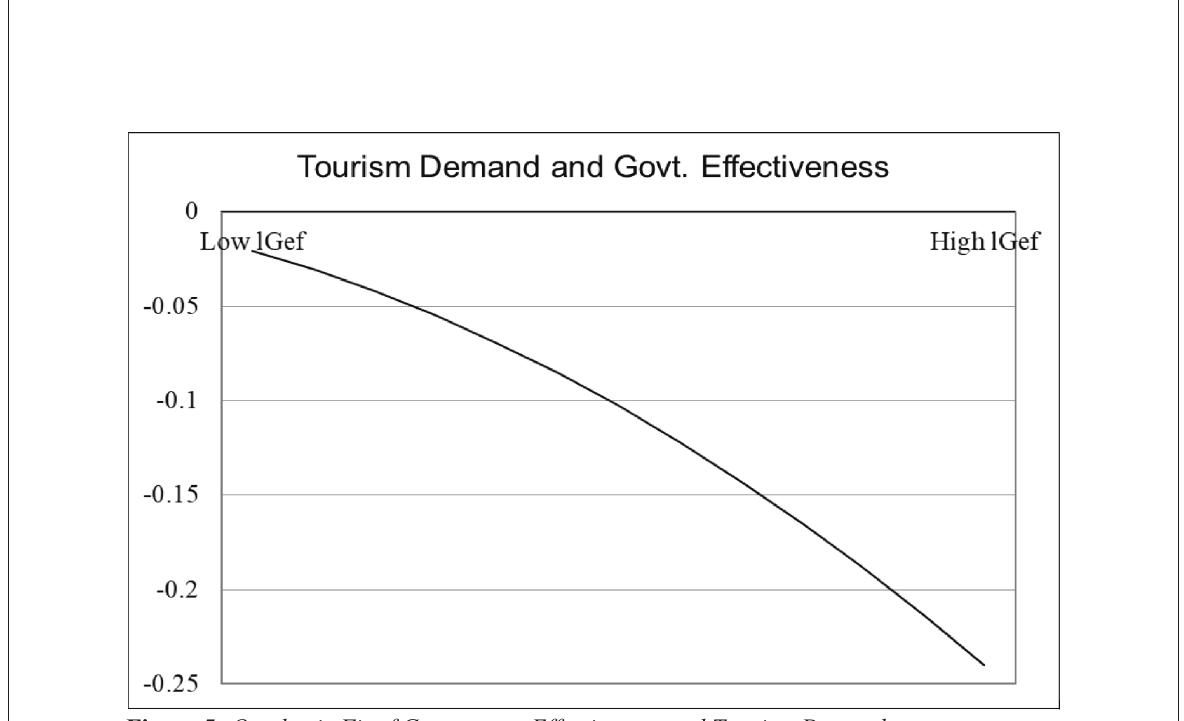
Figure 5: Quadratic Fit of Government Effectiveness and Tourism